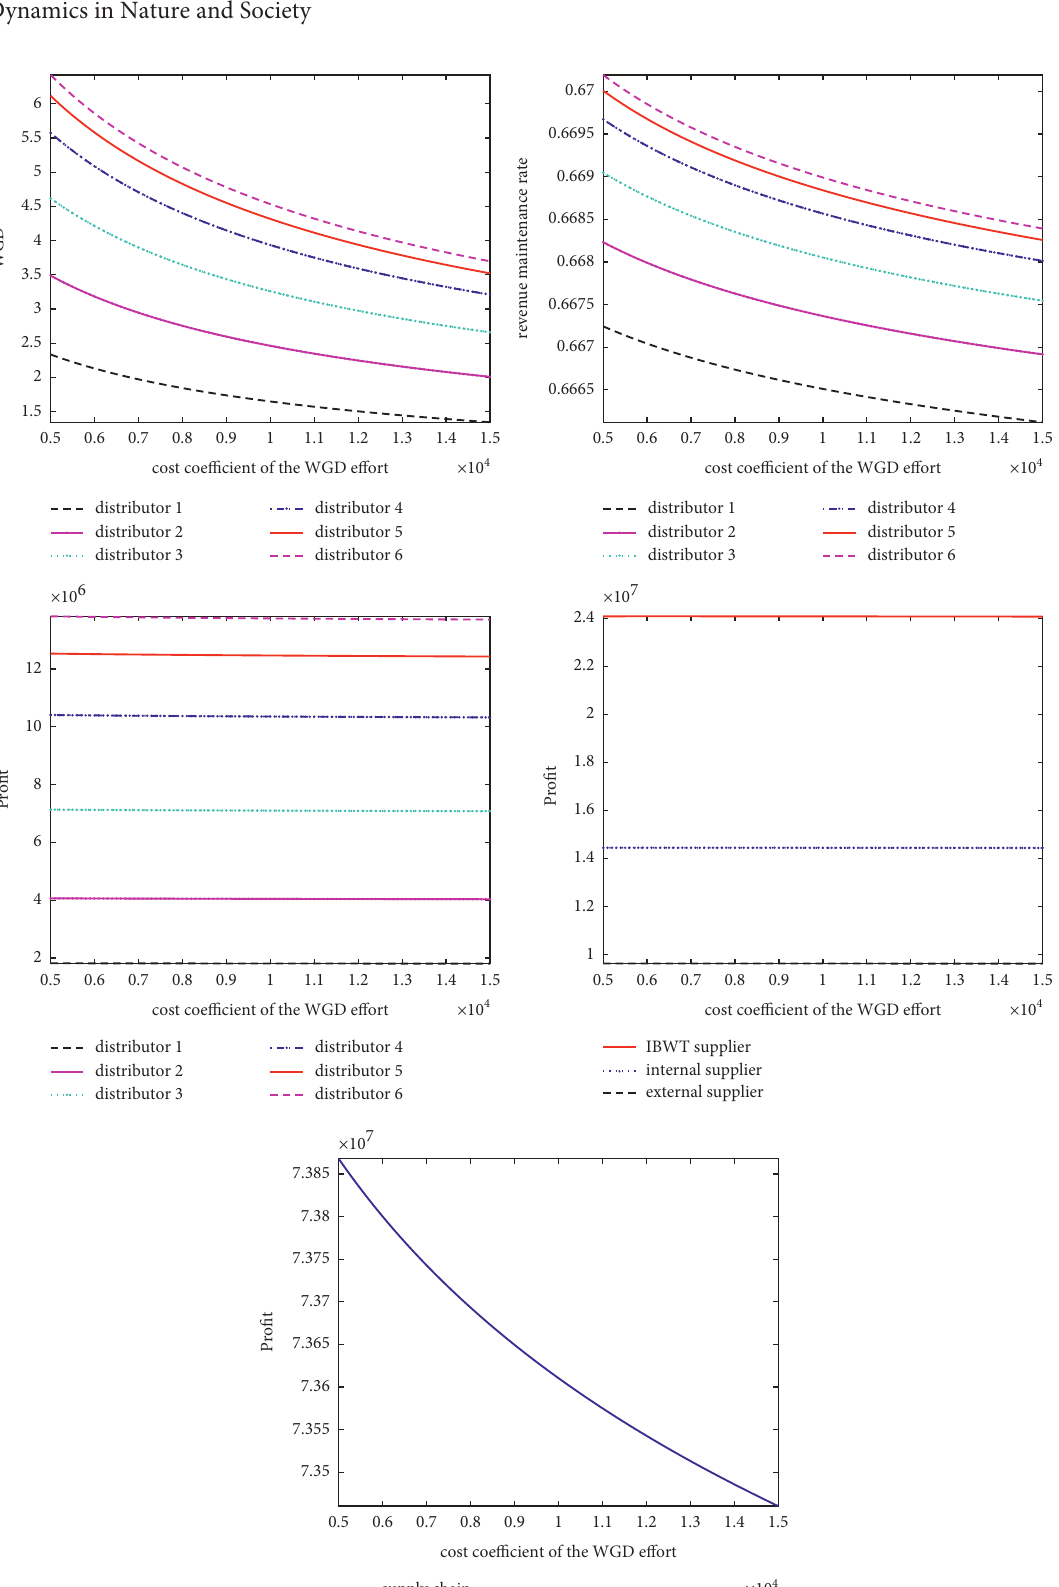
Figure 1: Sensitivity analysis of cost coefficient of the WGD effort ( κ